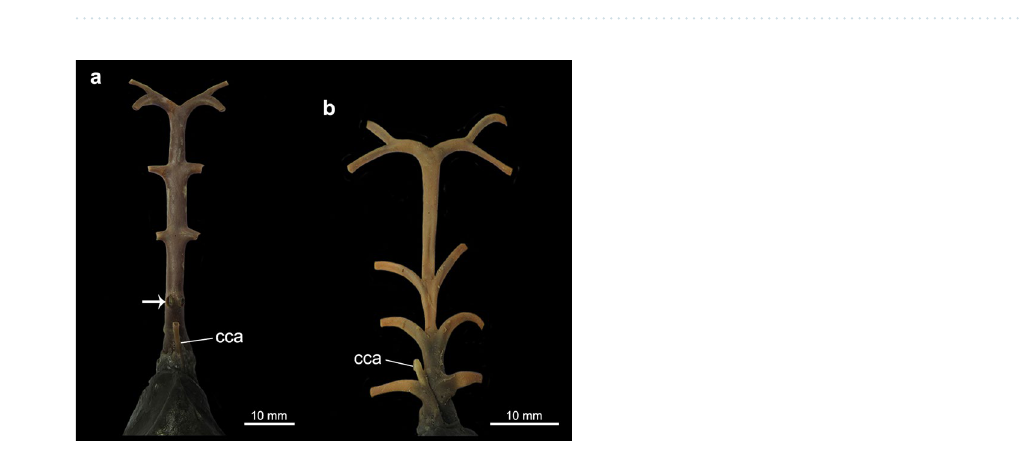
Figure 8. Dorsal view of the region of ventral aorta and afferent branchial arteries of ( a ) Mobula hypostoma and ( b ) Negaprion brevirostris . Arrow points to the opening of the fourth afferent branchial artery. cca cranial coronary